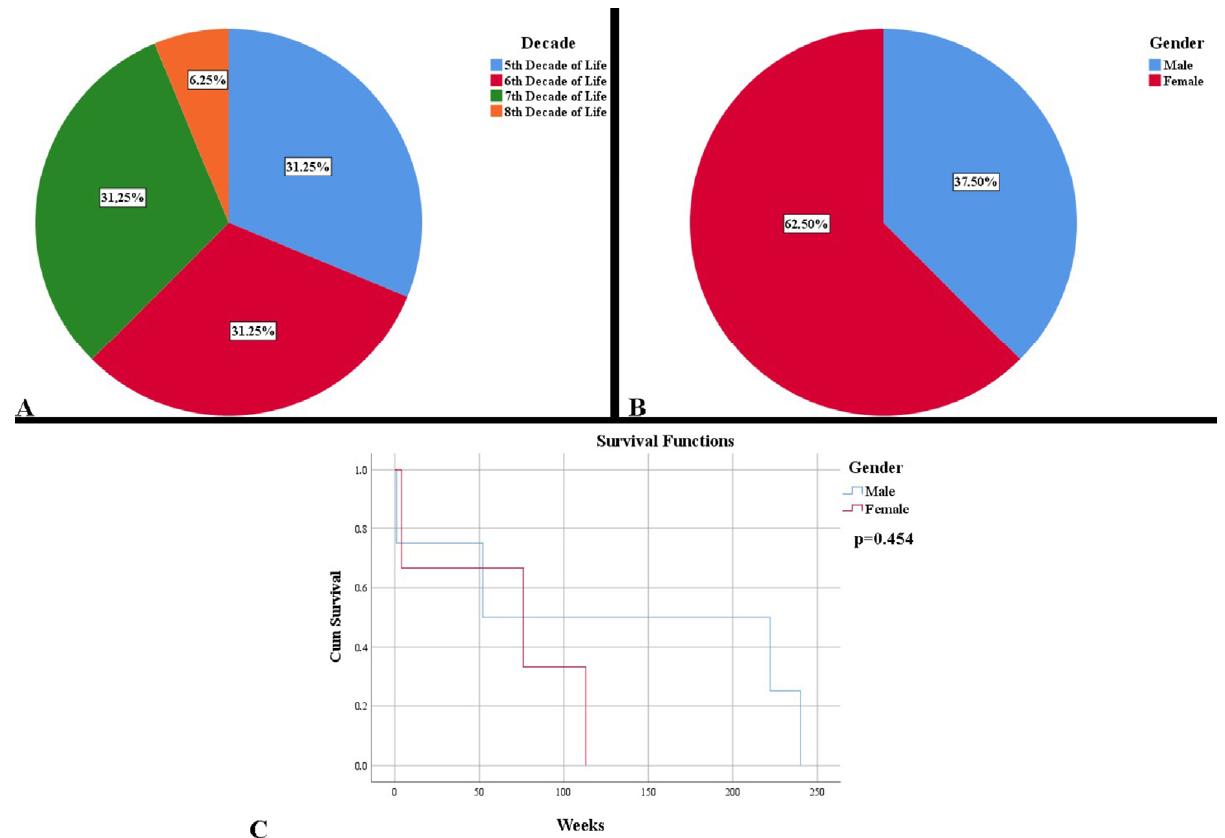
Figure 2. Demographic and clinical characteristics of low-grade gliomas. ( A ). Distribution of cases by decades of age. ( B ). Distribution of cases by gender. ( C ). Kaplan Meier survival graphic that shows a lower survival rate for females.